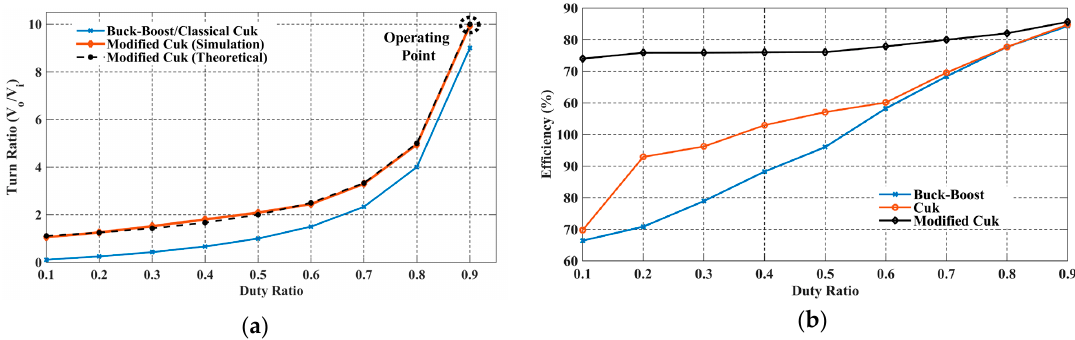
Figure 4. Comparison of buck/boost, Ć uk, and modified Ć uk converter. ( a ) Duty Ratio; ( b ) Efficiency.